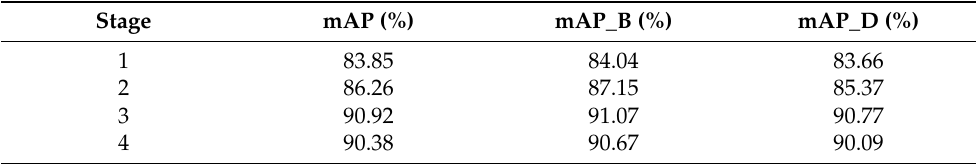
Table 7. Results of CrdNet on HL2019 test set using different numbers of cascade stages on